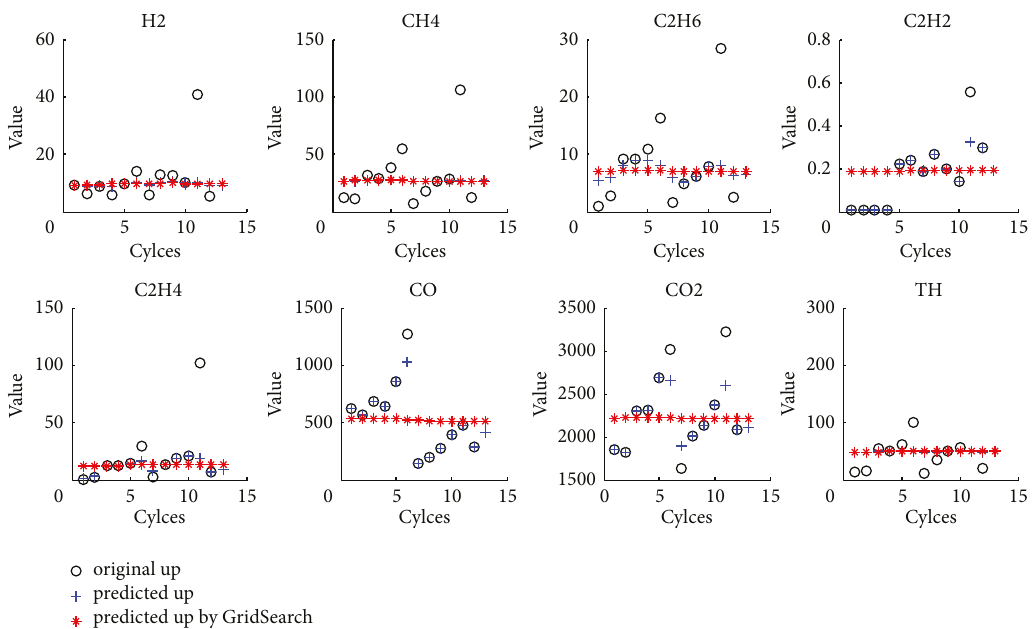
Figure 5: Original vs. predicted value by the SVM model and grid search optimized SVM